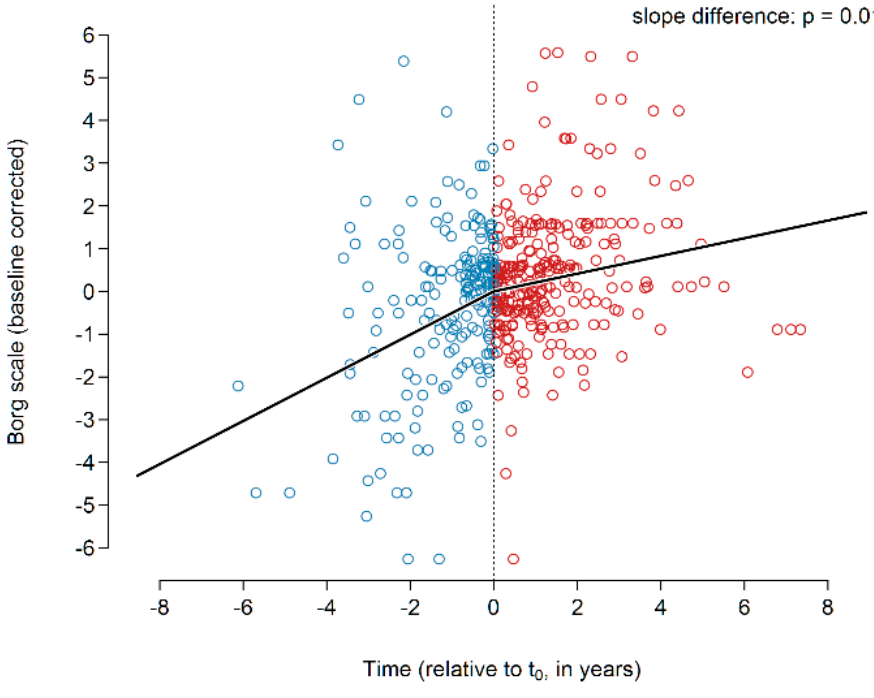
Figure 3 . Borg dyspnea scale before and during pirfenidone treatment.